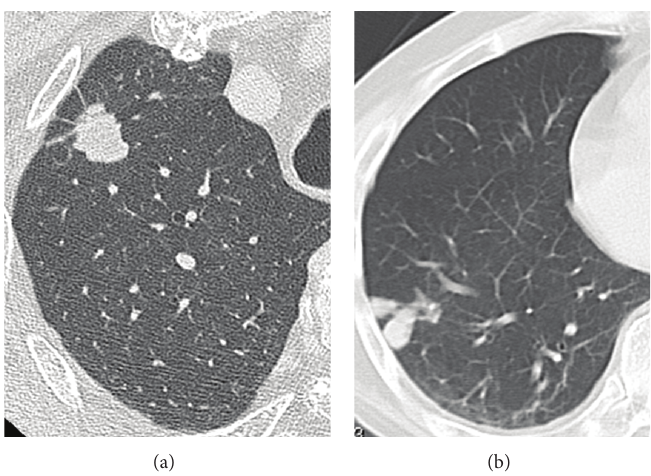
Figure 1: Representative chest CT images of pulmonary cryptococcosis of the nodule or mass without GGA/consolidation type. One patient showed a solid nodule with spiculation in the right upper lung (a). Another patient showed plural nodules, which had contact with the pleura in the right lower lobe (b).